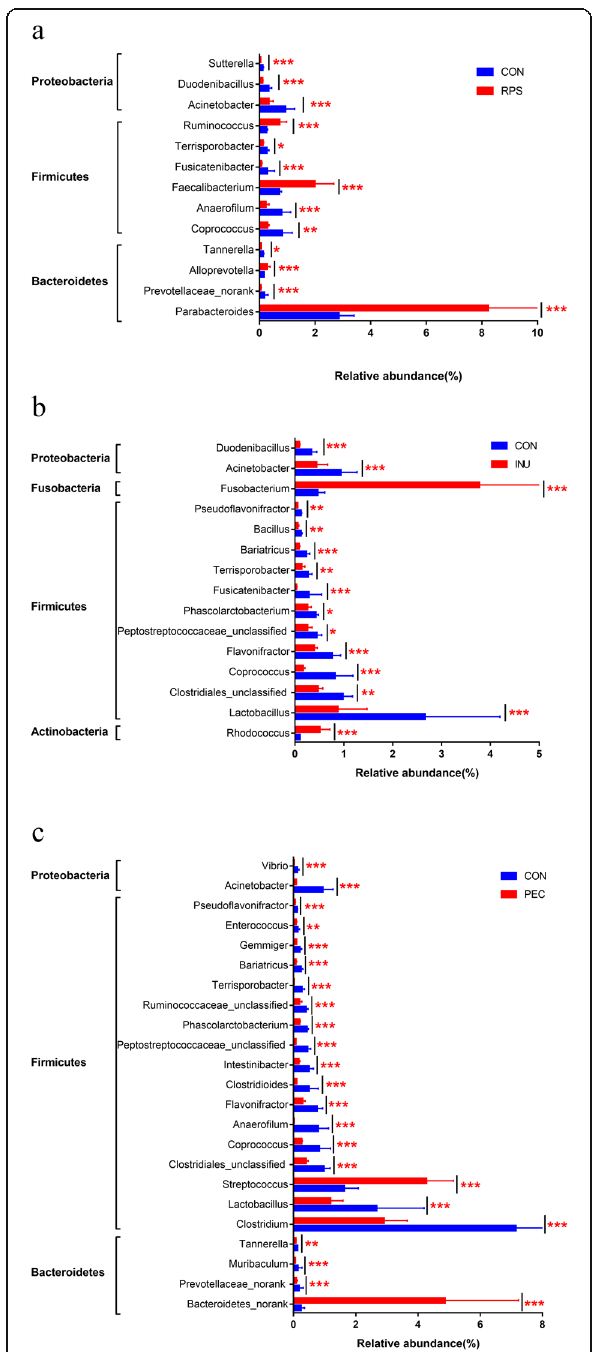
Fig. 4 Relative abundances (percentage) of microbial genera significantly affected by RPS ( a ), INU ( b ) and PEC ( c ) in the pigs ’ colon. CON, control diet; RPS, raw potato starch-enriched diet; INU, inulin-enriched diet; PEC, pectin-enriched diet. The FDR was calculated based on the p -value. *FDR < 0.05, **FDR < 0.01, ***FDR <